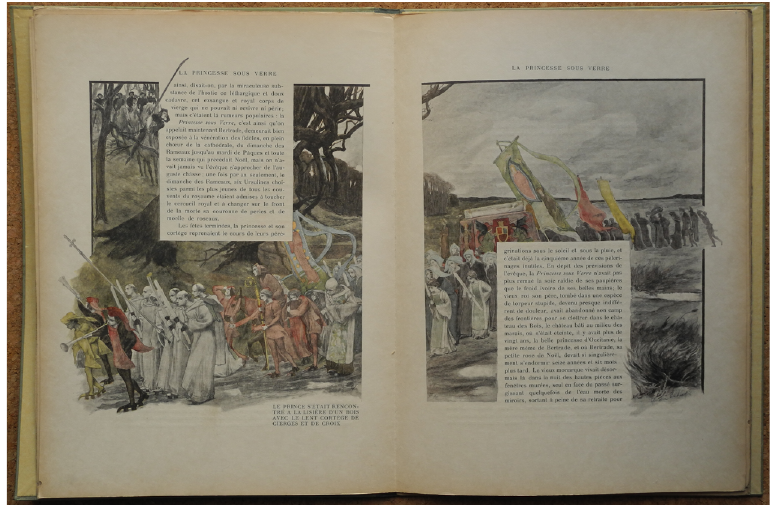
Fig. 5 Jean Lorrain, La Princesse sous Verre (Paris: Tallandier, [1896]), copy no. 5 on Japanese paper, printed by Draeger & Lesieur. Page layout after ‘La Princesse sous Verre’ [illustrations by André Cahard], Revue illustrée , no. 240 (1 December 1895), middle double spread. Private